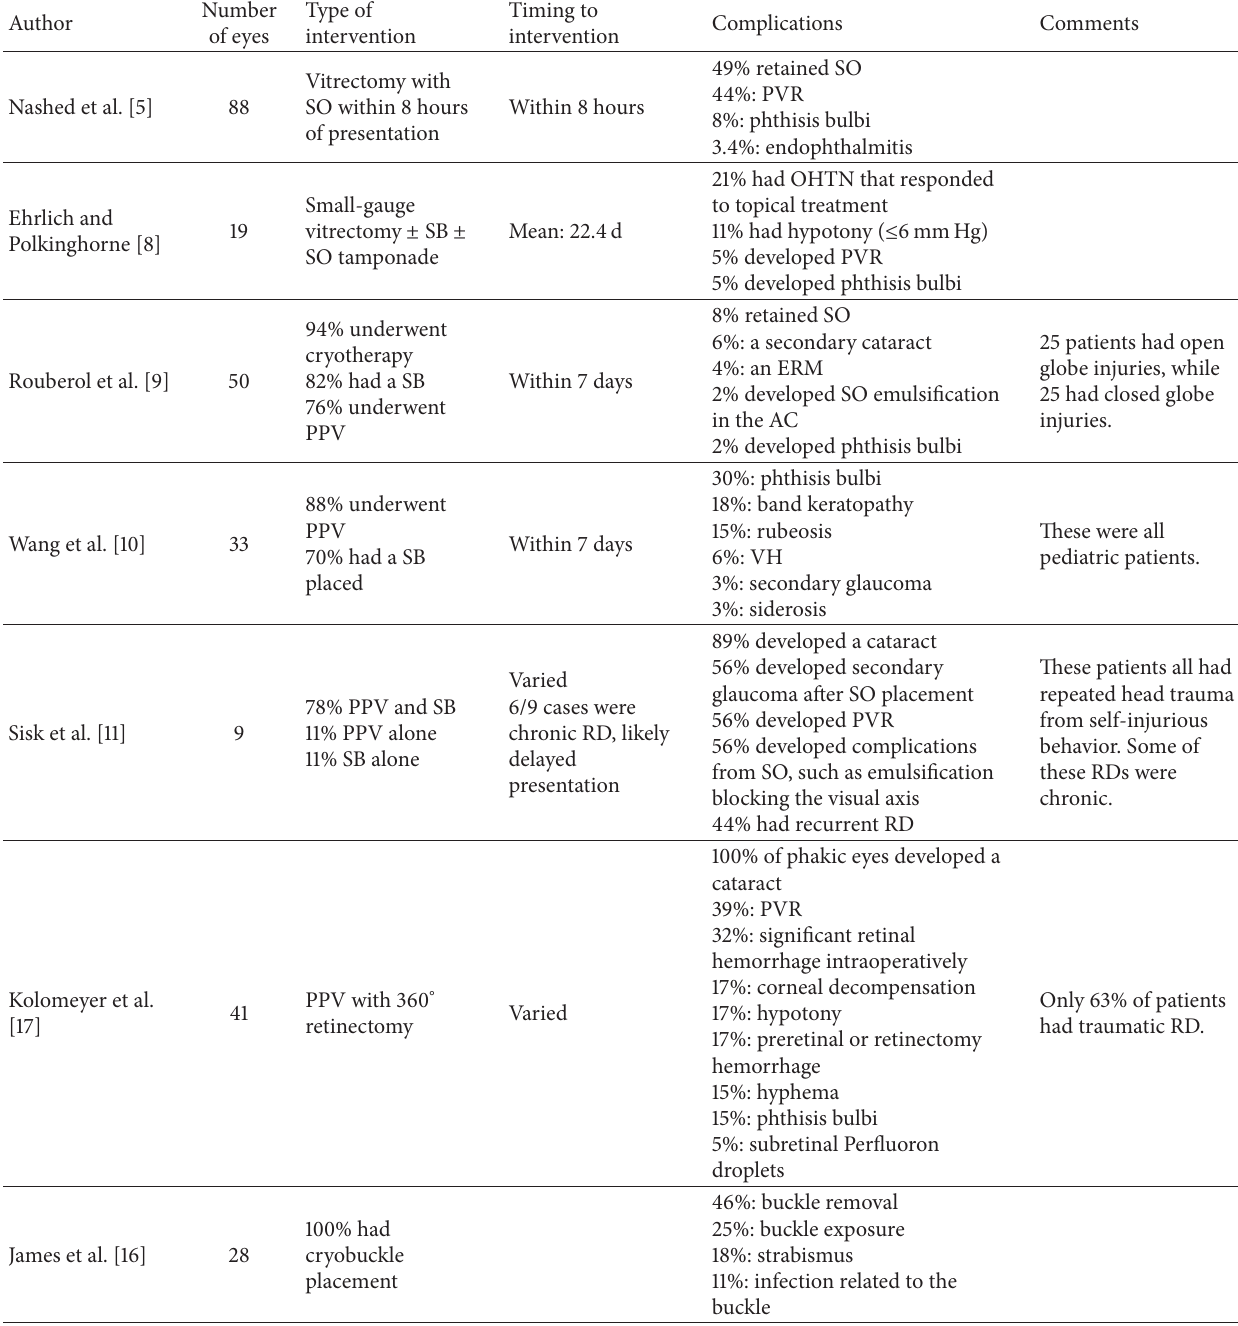
Table 6: Complications after surgery for traumatic retinal